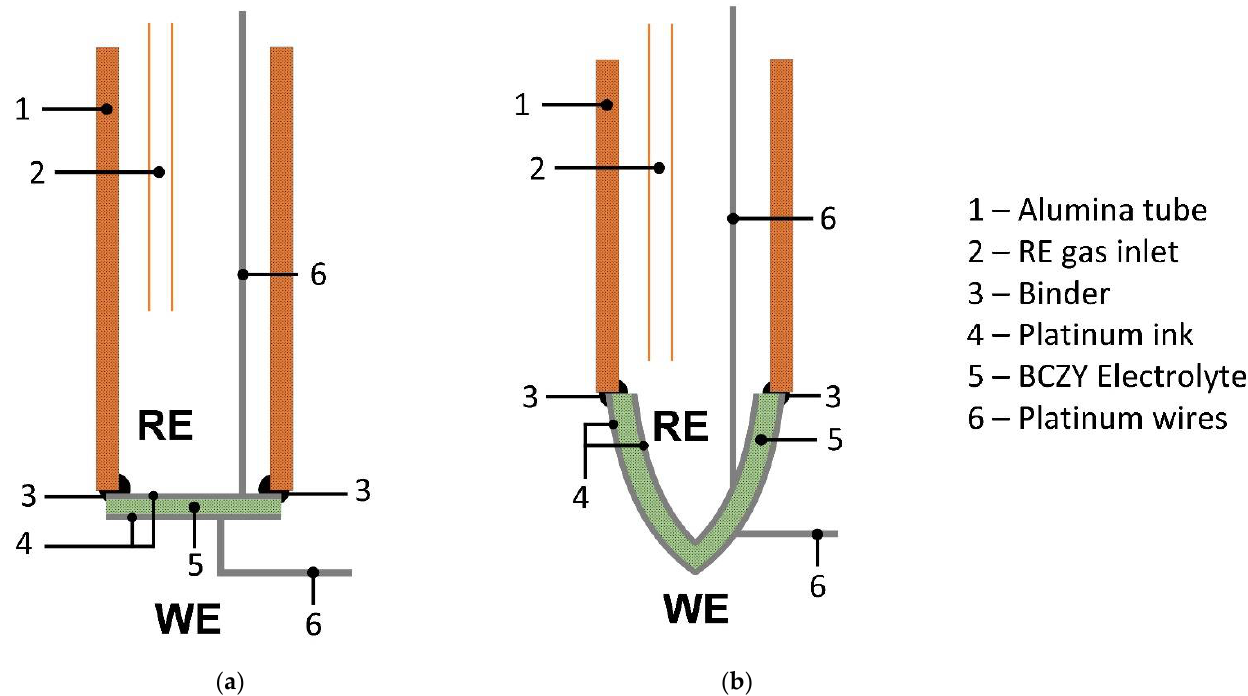
Figure 2. Schematic representation of the potentiometric sensors constructed with BCZY electrolyte shaped as ( a ) BCZY-Pellet and ( b ) BCZY-Crucible. WE: working electrode; RE: reference electrode.